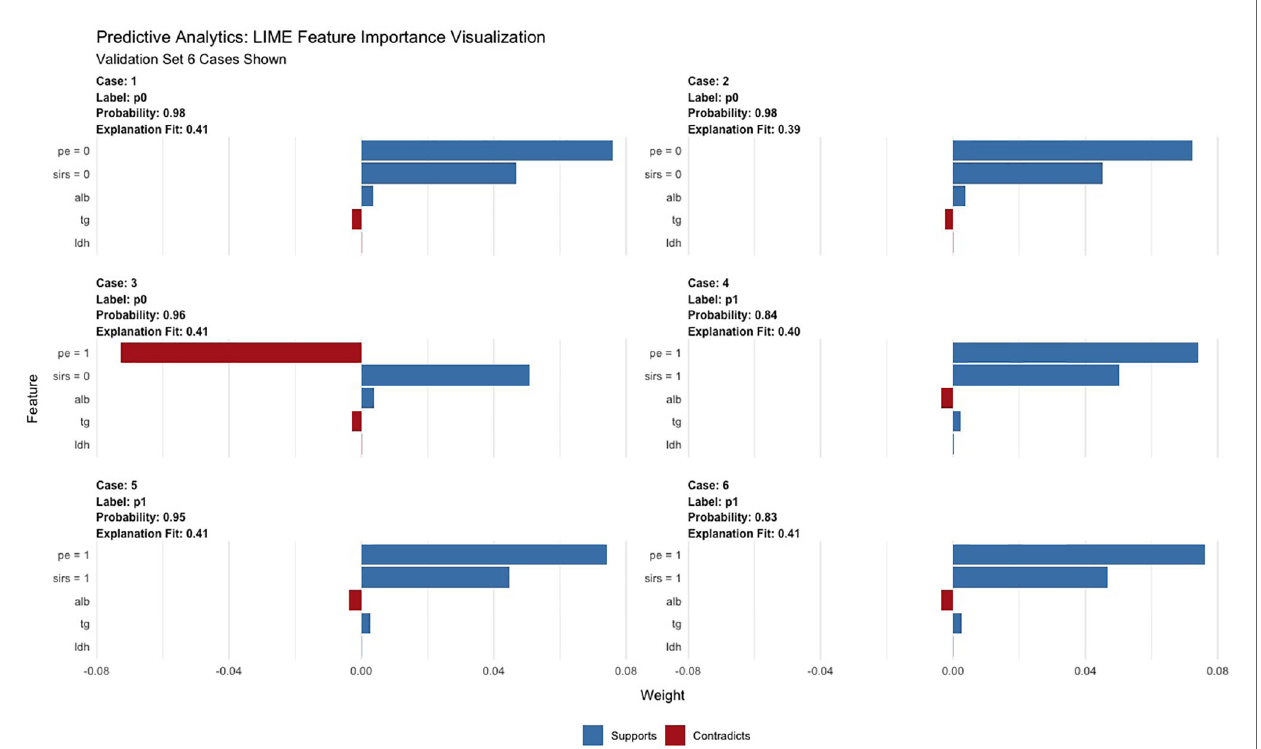
FIGURE 5 | LIME of the GBM model in the test set. LIME, Local Interpretable Model Agnostic